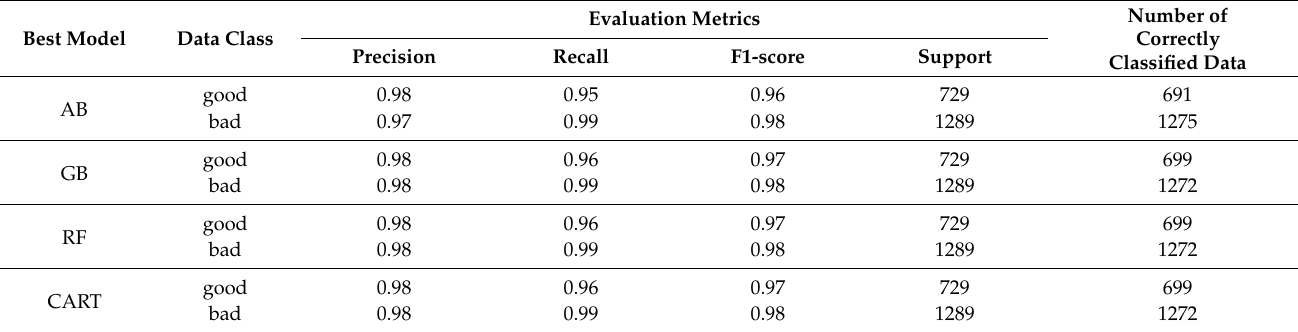
Table 8. Precision, recall, f1-score, and support values obtained using the testing